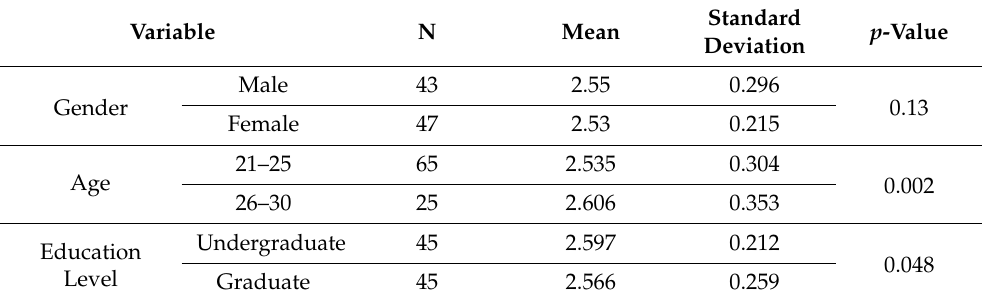
Table 4. Respondents’ demographic